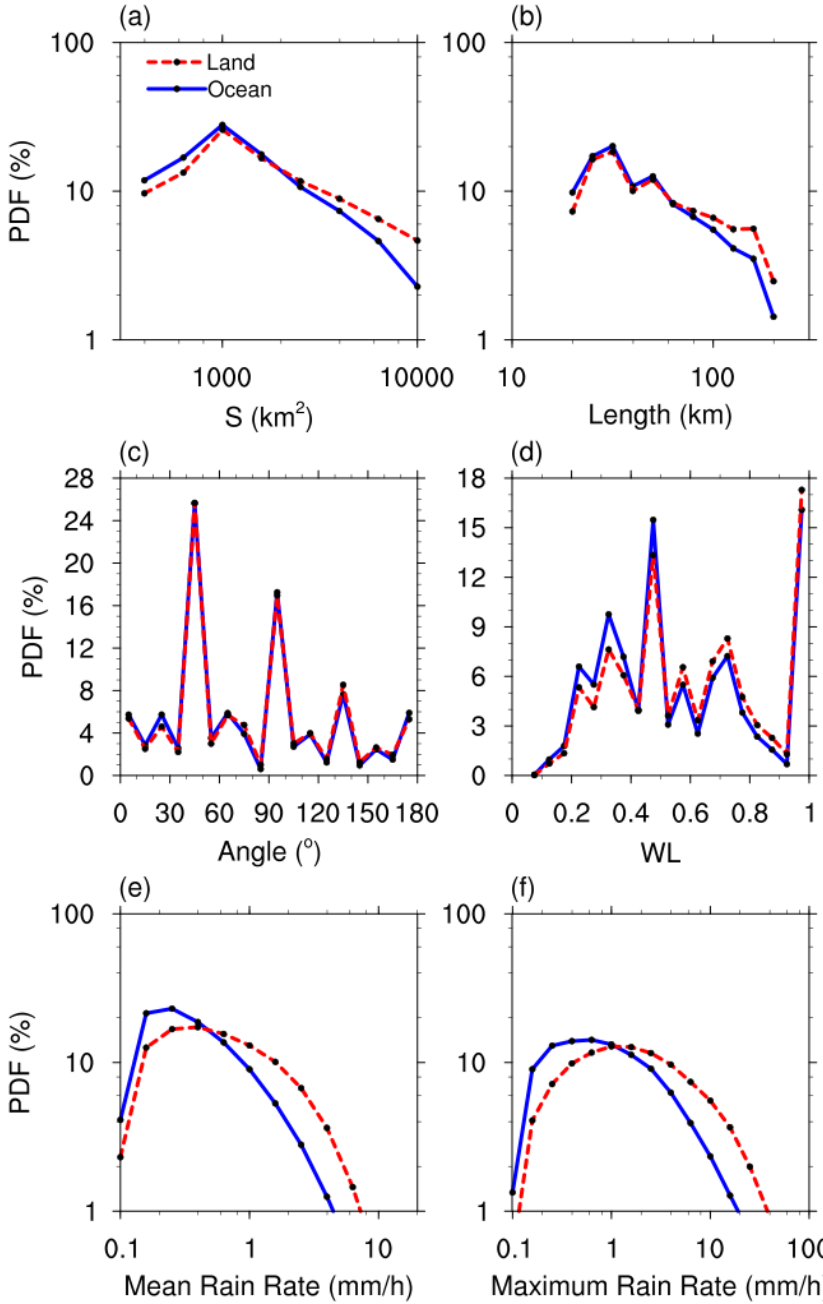
Figure 3. PDFs of the parameters of oceanic and continental rain clusters: ( a ) S , ( b ) length, ( c ) rotation angle, ( d ) WL , ( e ) mean rain rate and ( f ) maximum rain rate. The red dotted and blue solid lines represent continental and oceanic rain clusters, respectively.